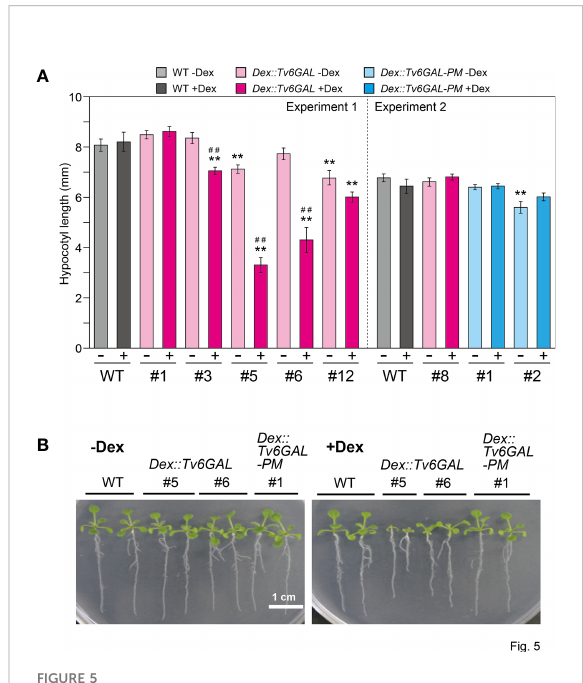
FIGURE 5 Phenotypes of Dex::Tv6GAL plants. (A) Length of dark-grown hypocotyls. Dex::Tv6GAL and Dex::Tv6GAL-PM plants were grown on MS-agar plates with and without 10 µM Dex in the dark at 23°C for 5 days. The data show mean values with ± SD. n = 20. Asterisks indicate signi fi cant differences from WT plants (Student ’ s t -test, **, P <0.01) and hash marks indicate signi fi cant differences between seedlings with and without Dex treatment (Student ’ s t -test, ##, P <0.01). Representative plants are shown in Supplementary Figure S3. (B) Light-grown seedlings. The seedlings were grown on MS-agar plates with and without 10 µM Dex under continuous light at 23°C for 2 weeks. Representative plants were